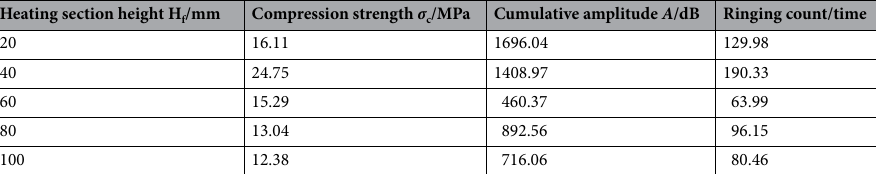
Table 2. Correlative parameters required for acoustic emission parameter inversion of coal sample